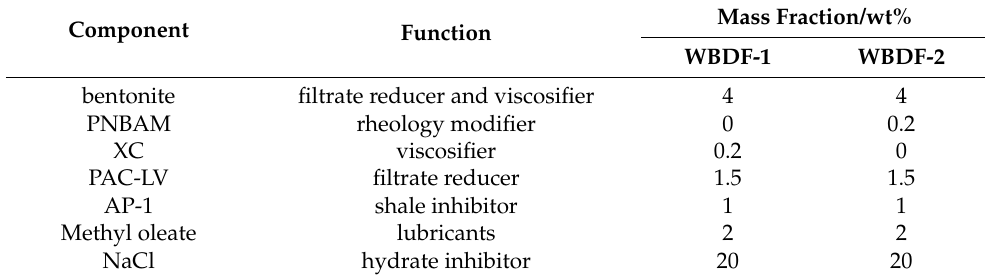
Table 6. Composition of the